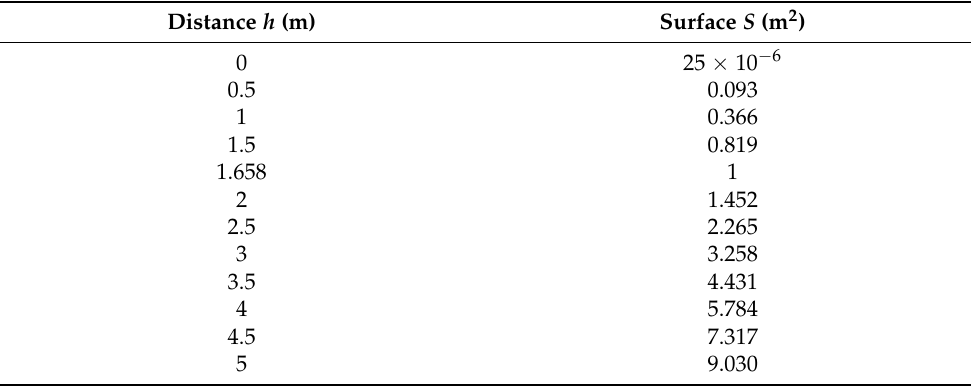
Table 1. Projection surface size in function of the distance from the aperture.